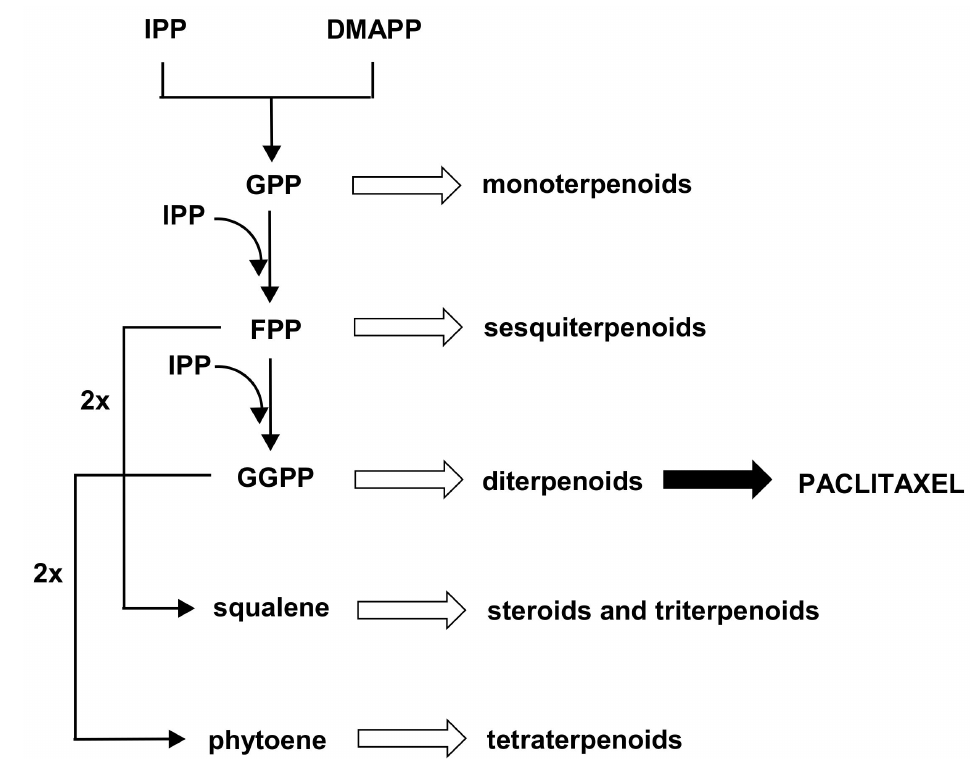
Figure 1. The scheme of the general pathway of terpenoid biosynthesis, regardless of the MVA (mevalonate) or MEP (methylerythritol phosphate) origin of precursors. IPP, isopentenyl diphosphate; DMAPP, dimethylallyl diphosphate; GPP, geranyl diphosphate; FPP, farnesyl diphosphate; GGPP, geranylgeranyl